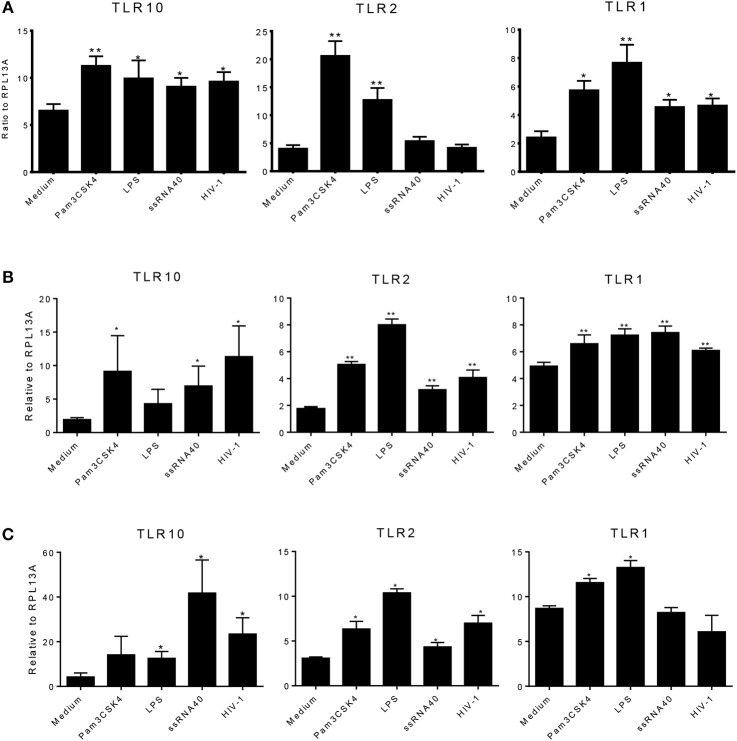
Effects of PAMPs and HIV-1 on the level of TLR expression in cell cultures. (A) qRT-PCR of TLR10, TLR2, and TLR1 mRNA from MCF-10A cells treated with TLR2 PAMP Pam3CSK4, TLR4 PAMP LPS, TLR7/TLR8 PAMP ssRNA40, and cell-free HIV-1 BAL. (B) q-RT-PCR in THP-1 cells. (C) qRT-PCR in primary BM cells. Data set is representative of three different experiments completed in triplicate. Statistic marks: *p < 0.05, **p < 0.01 for the Mann-Whitney t-tests, each group compared to medium-treated group (Medium).